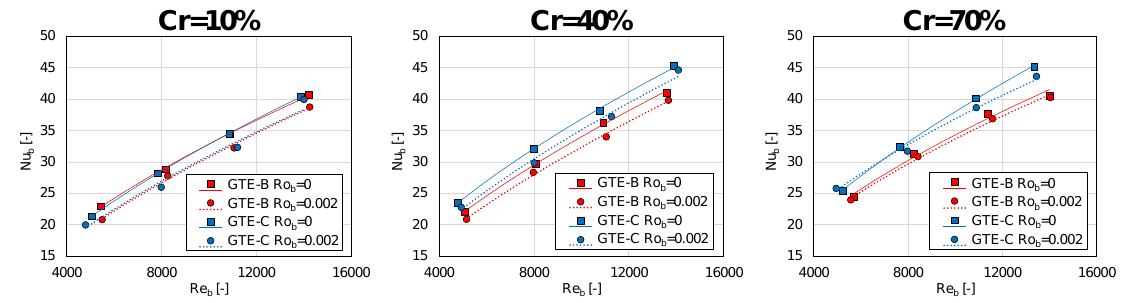
Figure 6. Nu b area averaged values for different crossflow